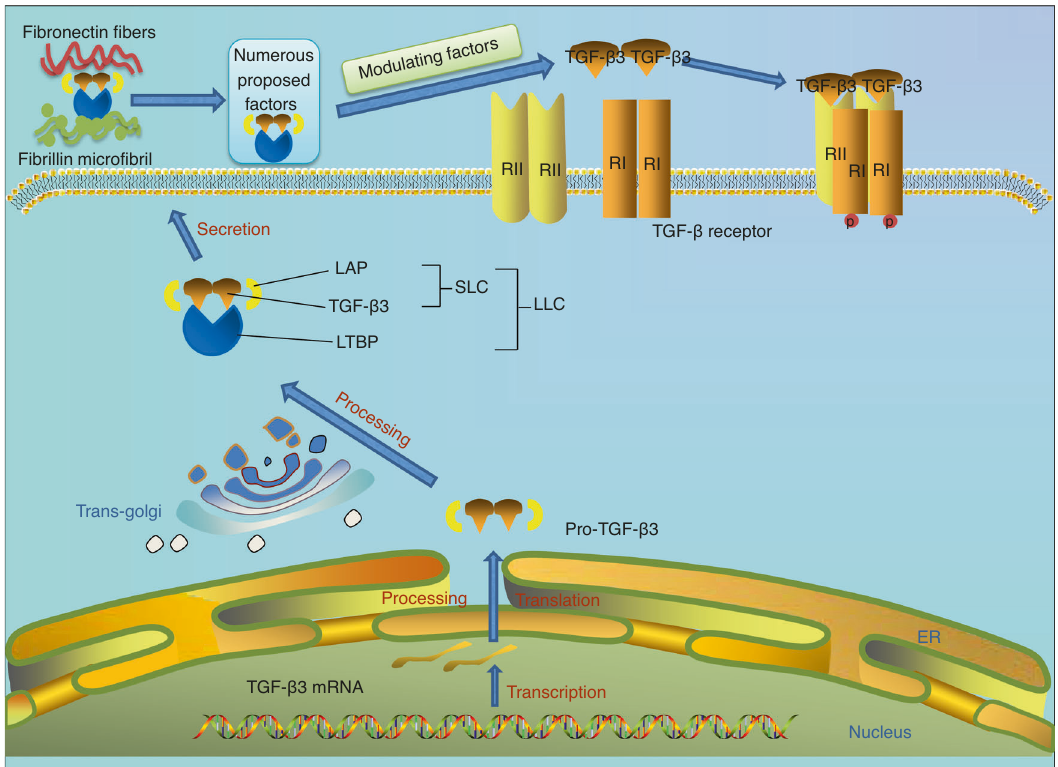
Fig. 1 Schematic diagram showing the synthesis, proteolytic processing, secretion and activation of transforming growth factor-beta 3 (TGF- β 3). TGF- β 3 is produced through mRNA transcription and is transported to the cytoplasm. A pro-TGF- β 3 homodimer consisting of the latency- associated peptide (LAP) and TGF- β 3 is generated in the endoplasmic reticulum (ER) and then transported to the trans-Golgi network. In the Golgi apparatus, pro-TGF- β 3 is further processed to form a small latent TGF- β 3 complex (SLC). The SLC connects with the latent TGF- β 3- binding protein (LTBP) and forms the resultant protein, the large latent TGF- β 3 complex (LLC). LLC is secreted outside the cell and binds to various molecules in the extracellular matrix. Finally, the conformation of the LLC is change by modulating factors, leading to the release of the activated and mature TGF- β 3. Activated TGF- β 3 binds to corresponding receptors on the cell